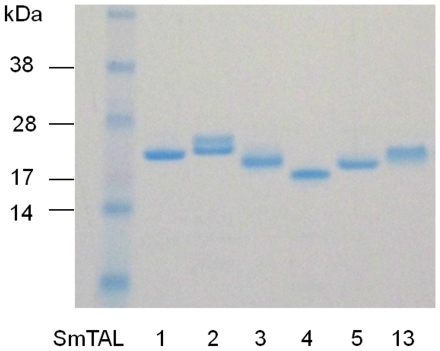
Electrophoresis of purified SmTAL proteins.2 µg of each of the indicated proteins was run under reducing conditions on a 4–12% gradient SDS-PAGE gel and stained with Coomassie blue.